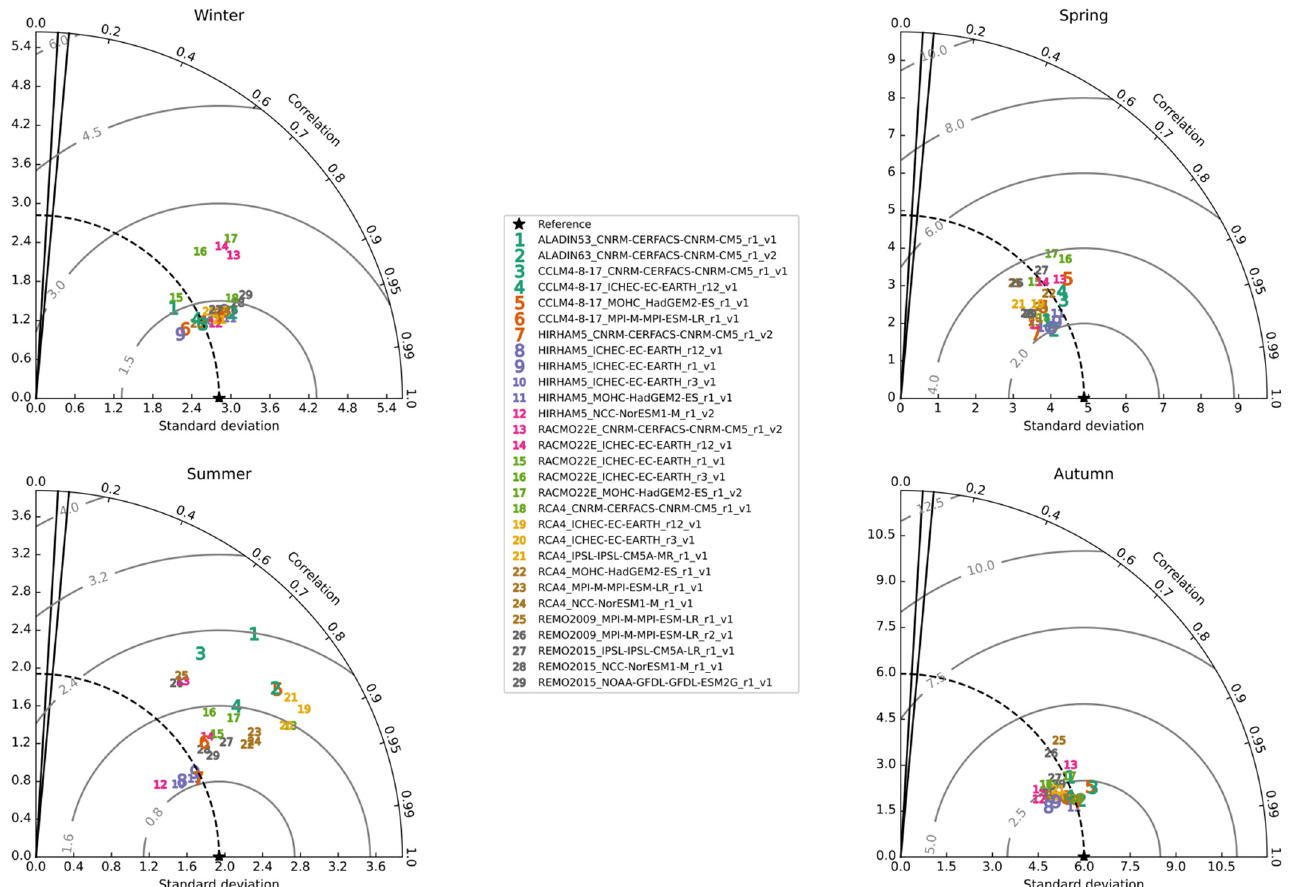
Figure 10. Taylor diagrams of seasonal (1971–2000) maximum temperature showing standard deviation (°C), centered RMSE (°C), and spatial correlation for each EURO-CORDEX GCM–RCM simulation versus E-OBS observations across the Pannonian Basin. The four panels refer to the four seasons defined as winter (DJF), spring (MAM), summer (JJA), and autumn (SON). The observed field is labeled with a star symbol. The dotted line depicts the contour of the reference standard deviation (the observed field). The RMSE contours are grayed out. The 95th and 99th significance levels are represented by the correlation rays on the left and right, respectively.